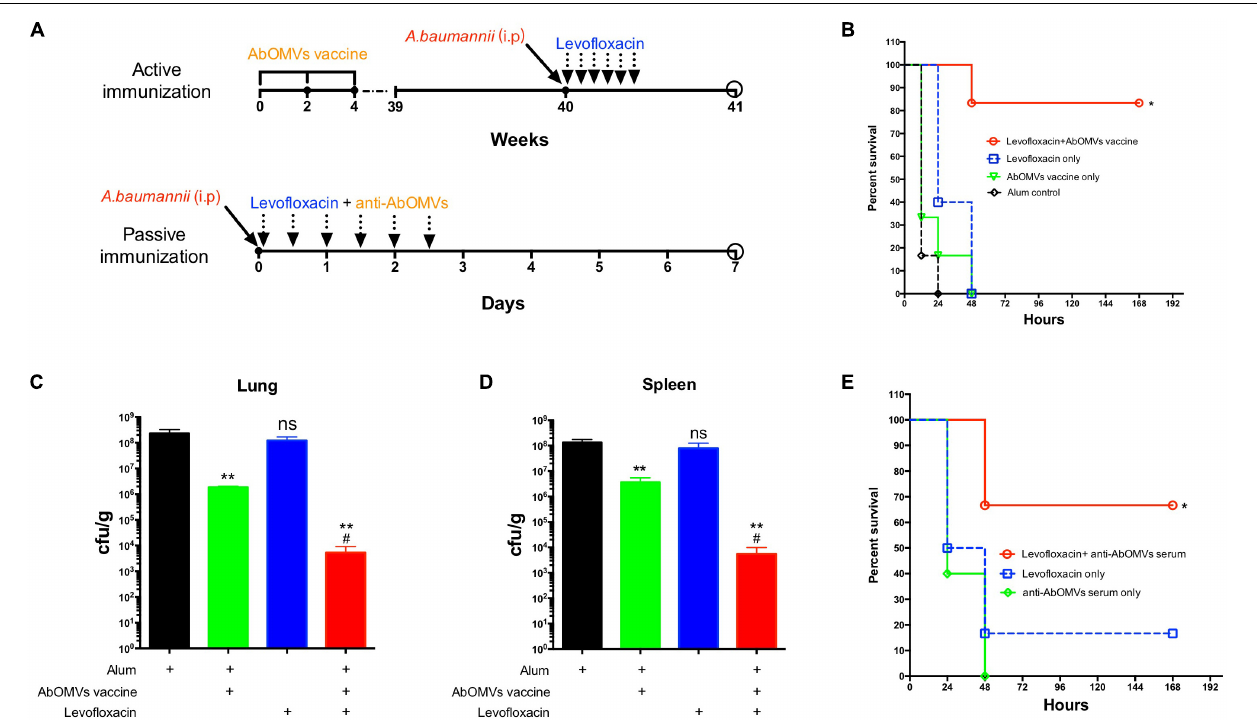
FIGURE 4 | Anti-AbOMV antibodies improved the susceptibility of drug-resistant A. baumannii to levofloxacin in the mouse sepsis model. (A) Schematic diagram of treatment of A. baumannii infection with active and passive immunization combined with antibiotics. (B) A. baumannii infection was treated with active immunization with AbOMVs combined with levofloxacin, and survival of the mice was observed continuously for 7 days. The bacterial loads of the (C) lung and (D) spleen 12 h after bacterial challenge. ∗ Represents the comparison between each group and the Alum control group; # represents the comparison with the AbOMV vaccine alone group. (E) Survival rate of mice infected with A. baumannii and treated with anti-AbOMV serum combined with levofloxacin. ∗ Indicates antibody-antibiotic combination or AbOMV vaccine compared with the Alum control; # indicates anti-AbOMVs combined with antibiotics compared with anti-AbOMVs alone; N = 5; ∗ / # P < 0.05; ∗∗ P <